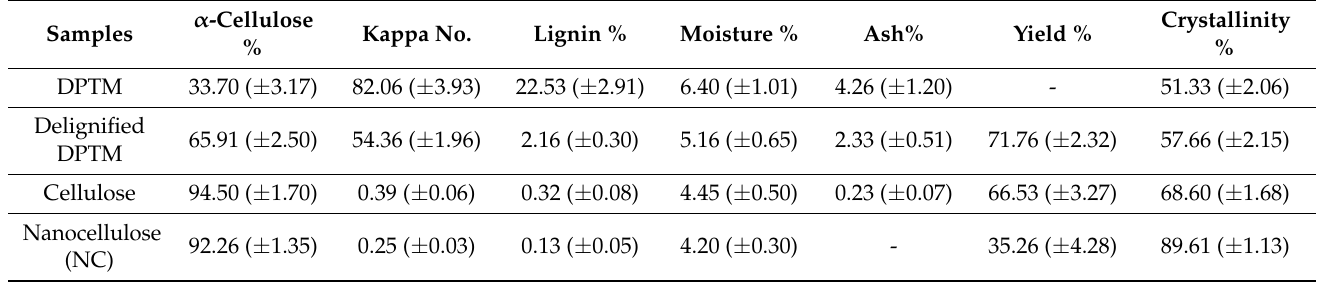
Table 1. Chemical composition of date palm trunk mesh